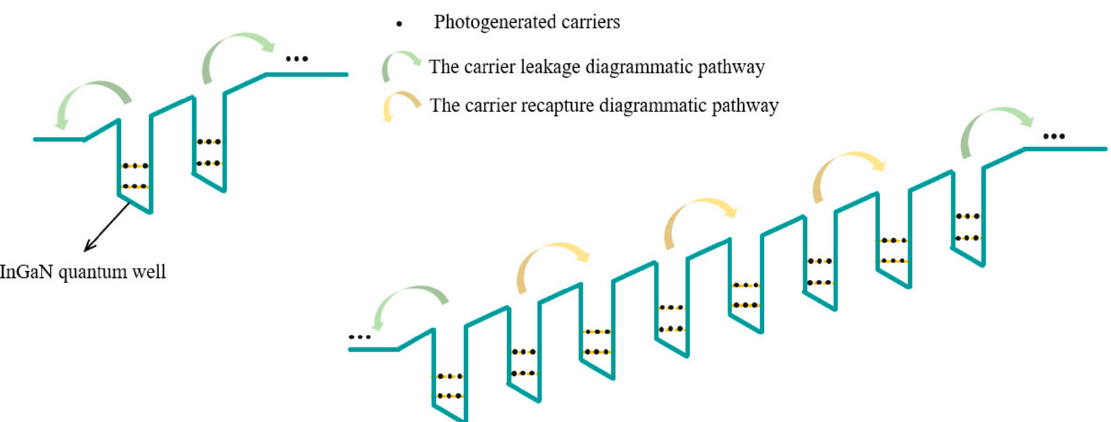
Figure 3. The schematic diagram of conduction band and carrier leakage pathway in sample 2QW and 8QW. Due to the larger number of well layers of sample 8QW, the carriers leaking out of quantum well are more likely to be recapture by another quantum well.